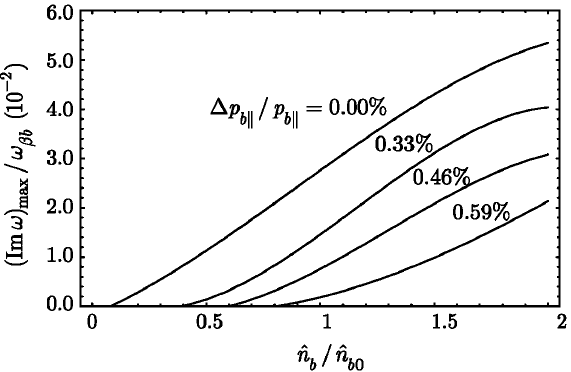
FIG. 2. Maximum growth rate versus normalized beam den- sity for different values of initial axial momentum spread of the beam ions.